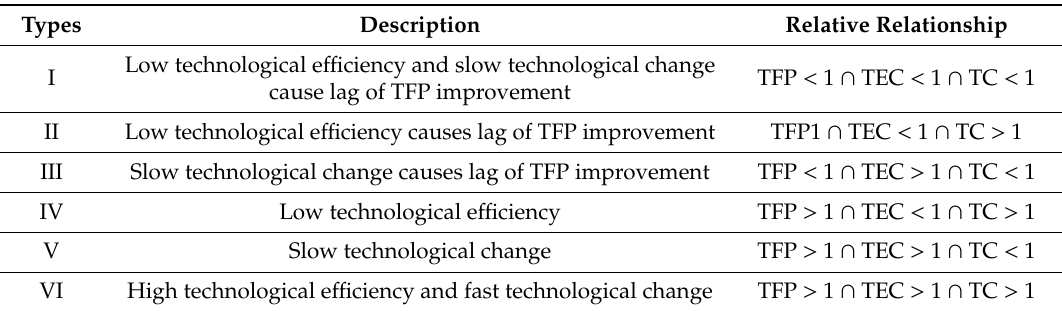
Table 2. Classification criteria for di ff erent types of agricultural development. TEC, technological e ffi ciency change; TC, technological